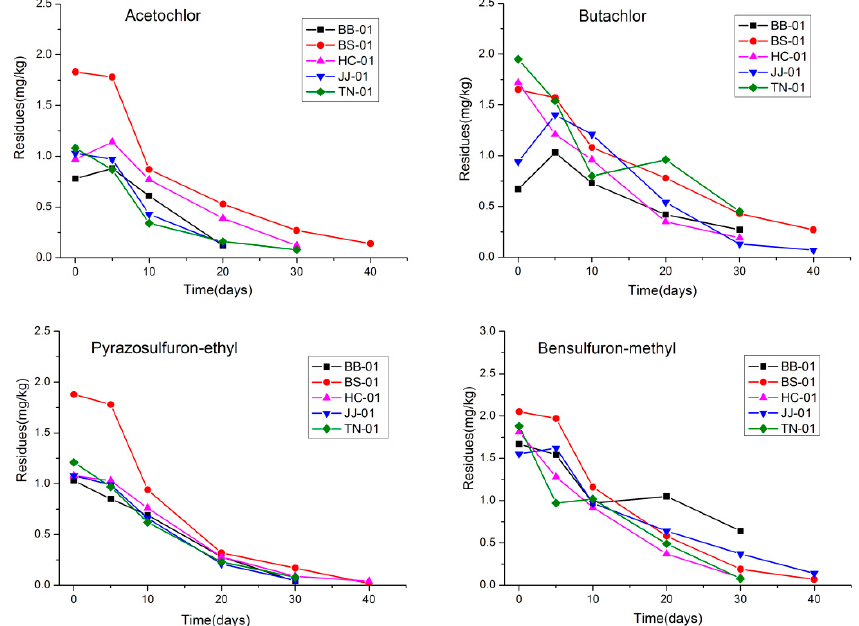
Figure 4. Representative dissipation curves of the four herbicides in soil samples in five different geographic zones after low-dosage application ( ■ , BB-01, ● , BS-01, ▲ , HC-01, ▼ , JJ-01, ◆ , TN-01).